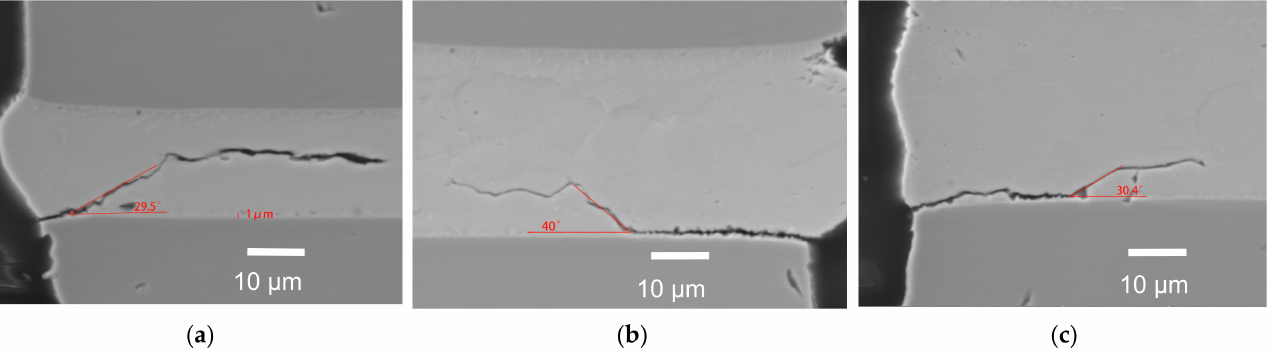
Figure 14. Cross section of the solder joint with different solder thicknesses, listed as: ( a ) 20 µ m; ( b ) 30 µ m; ( c ) 37 µ m.